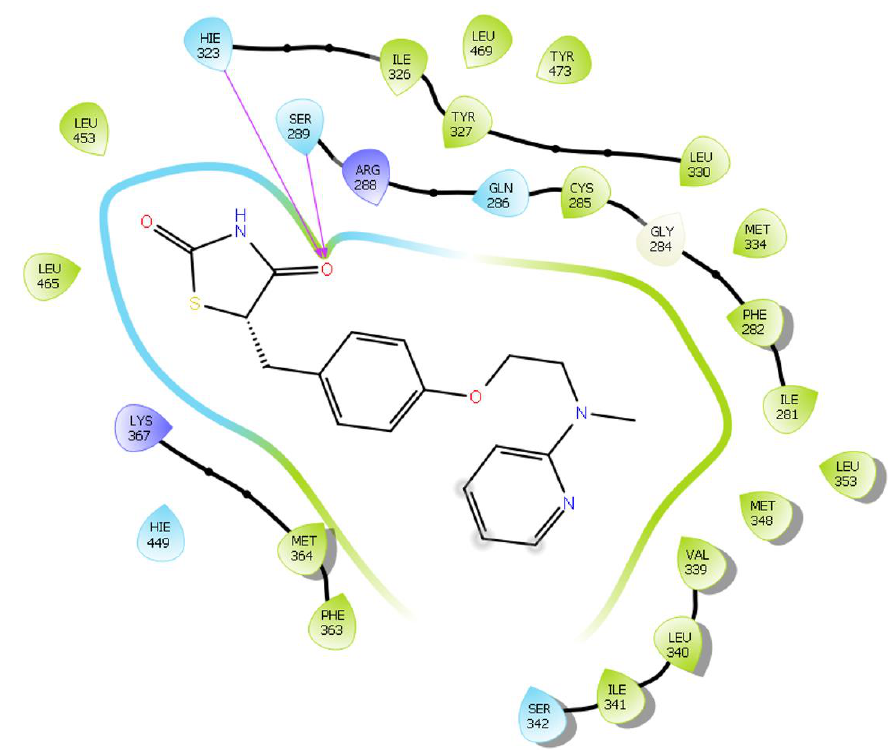
Figure 3. 2D interaction of the cross-docked ligand (rosi) with the receptor molecule.